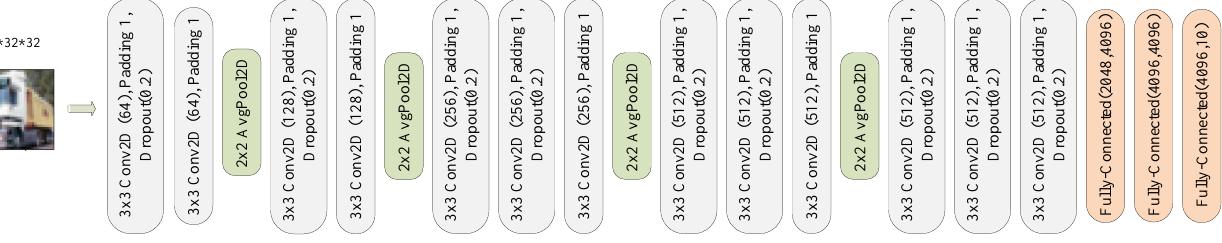
Figure A3. VGG-16 network architecture.